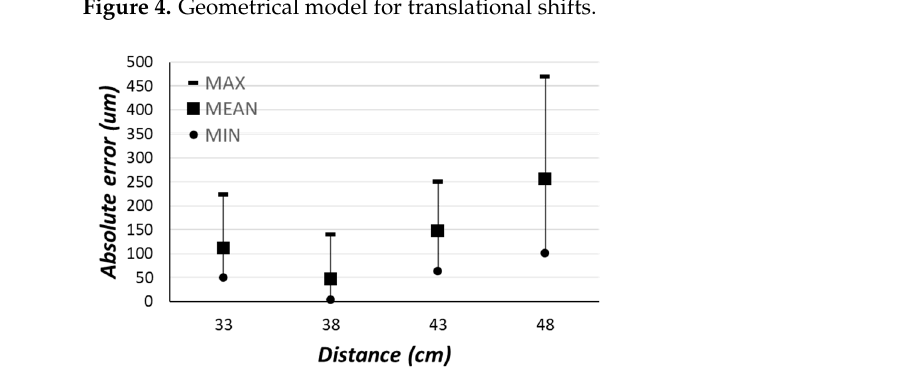
Figure 4. Geometrical model for translational shifts.